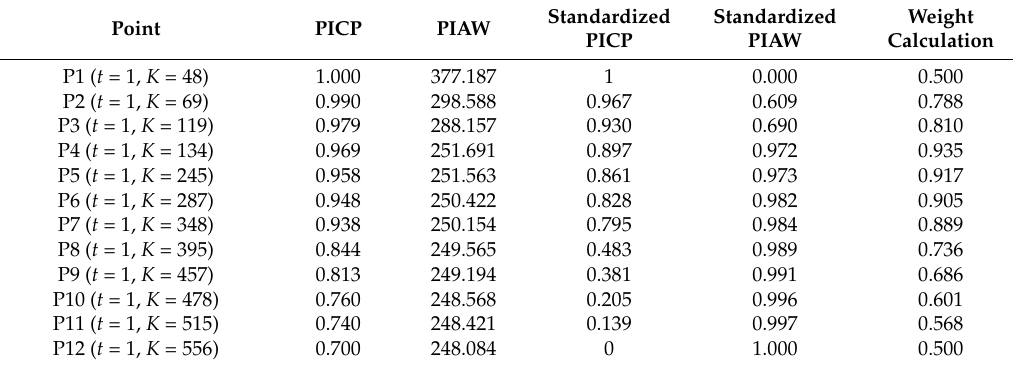
Table 3. Weight calculation results of the points in the Pareto optimal solutions set in region